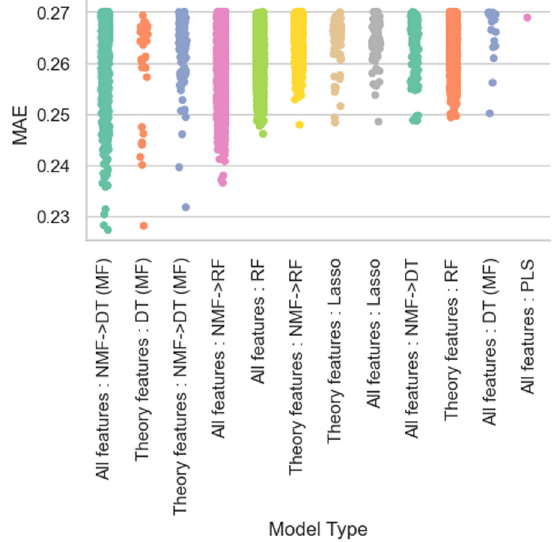
Fig. 1 The LOOCV performance of all models where MAE was < 0.27. Each point represents the performance of a distinct set of hyper- parameters within each model